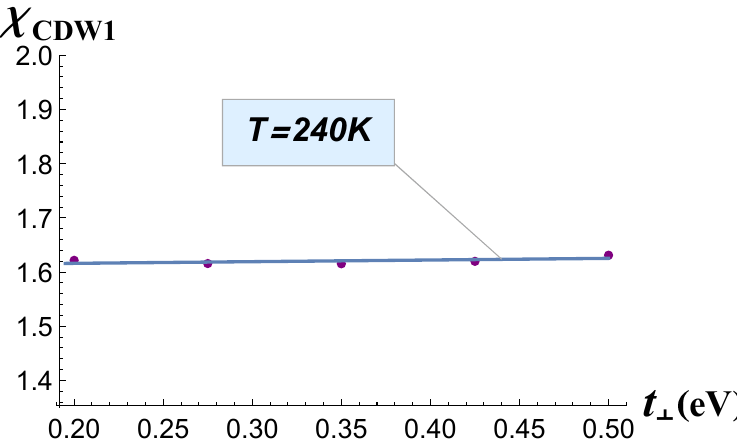
Figure 2. Electron susceptibility χ calculated at T = 240 K as a function of the electron hopping term t ⊥